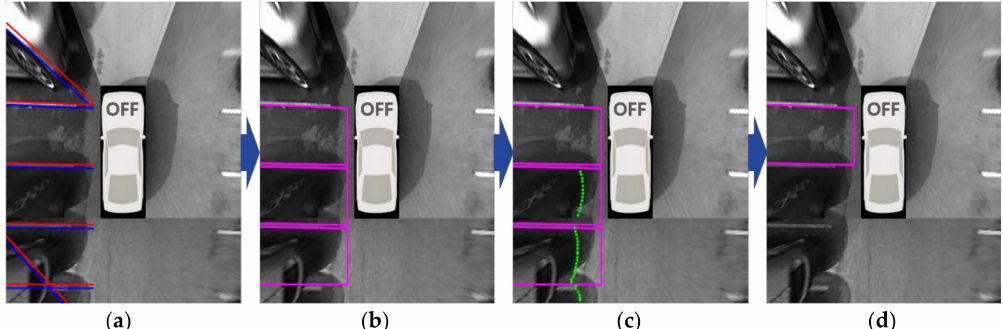
Figure 7. Parking slot candidate generation and occupancy classification. ( a ) Separating line detection results; ( b ) Parking slot candidate generation results; ( c ) Range data obtained by an ultrasonic sensor; ( d ) Parking slot candidates classified as